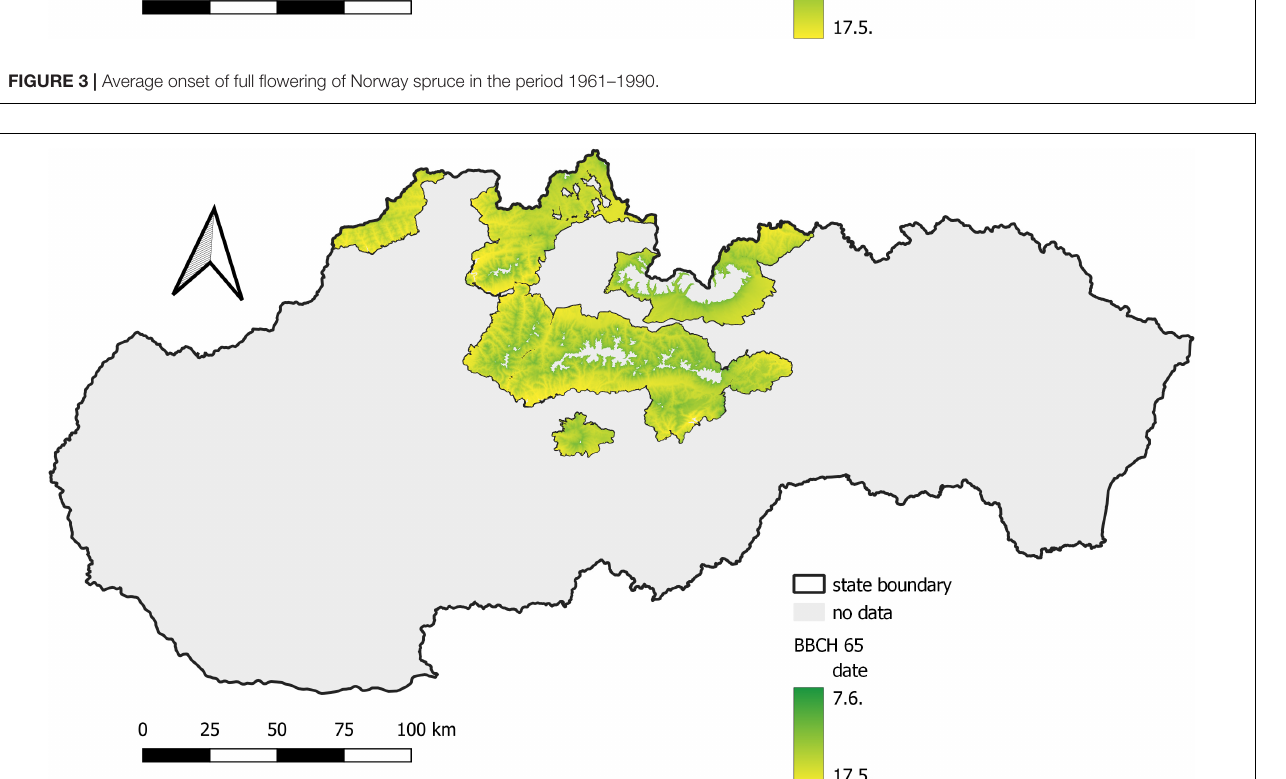
statistical characteristics indicate that climate change affects the phenological phase, since its onset along the elevational gradient was accelerated, and variability indicators (s x %, R) in all elevation classes were reduced in the second